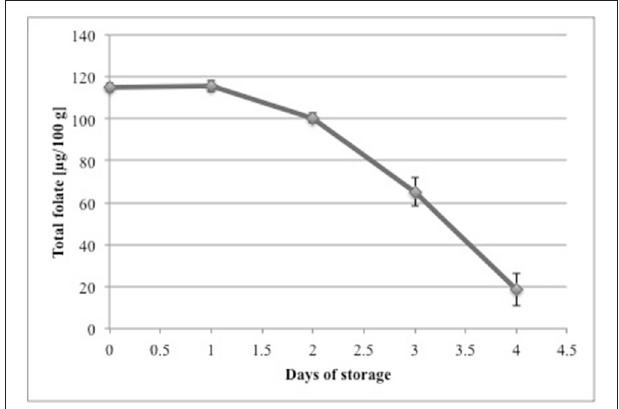
FIGURE 3 | Vitamers and total folate content calculated as PteGlu in [ µ g/100g] of three strawberry cultivars grown in Germany (1: cultivar 1, 2: cultivar 2, and 3: cultivar 3), an Australian cultivar grown in Queensland (4: Festival), and white strawberry breeding lines grown in Germany (5: P100120, 6: P100677, 7: P100696, and 8: F. nilgerrensis Mt. Leigong 2).